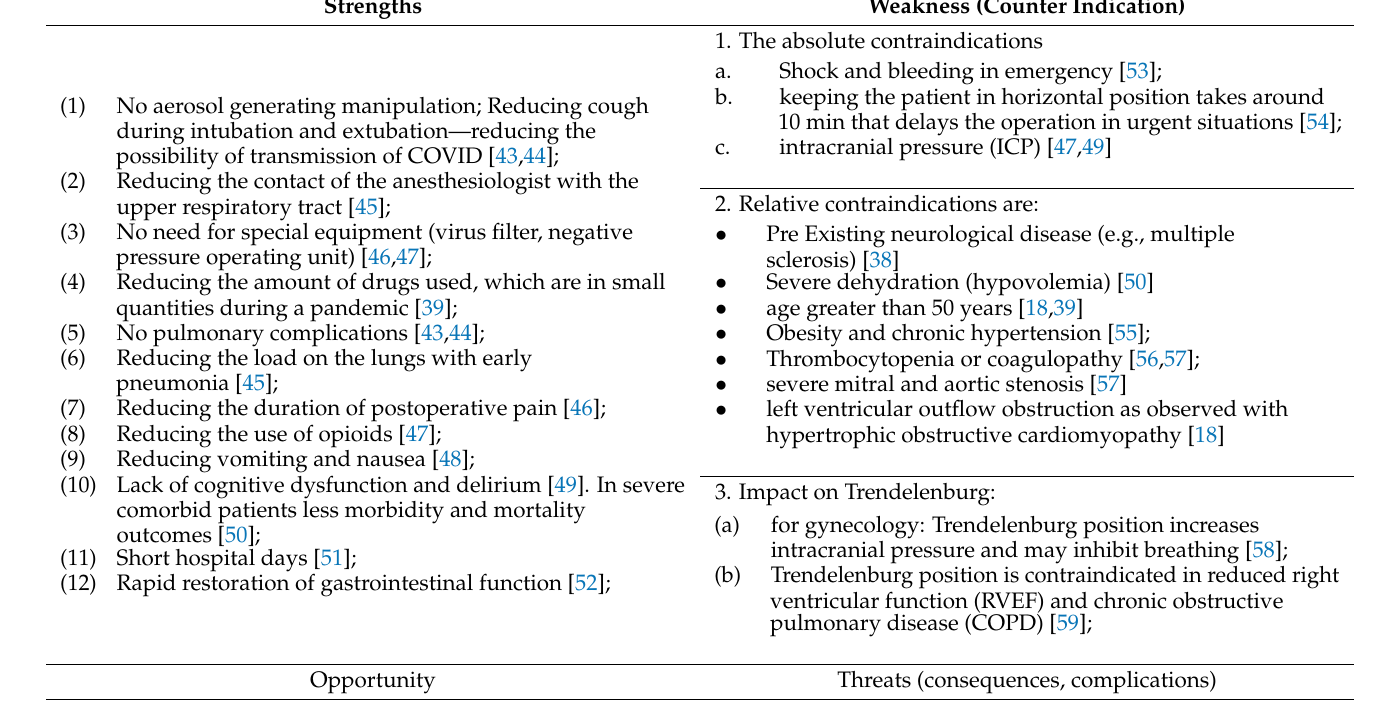
Table 3. SWOT analysis on regional anesthesia during